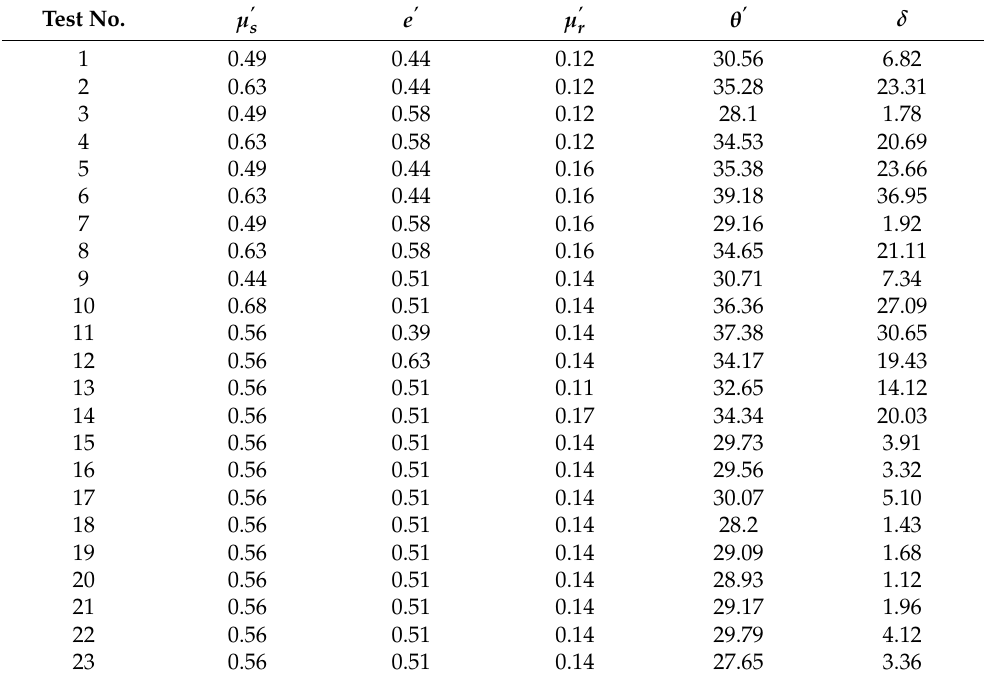
Table 5. Results of quadratic regression orthogonal rotating